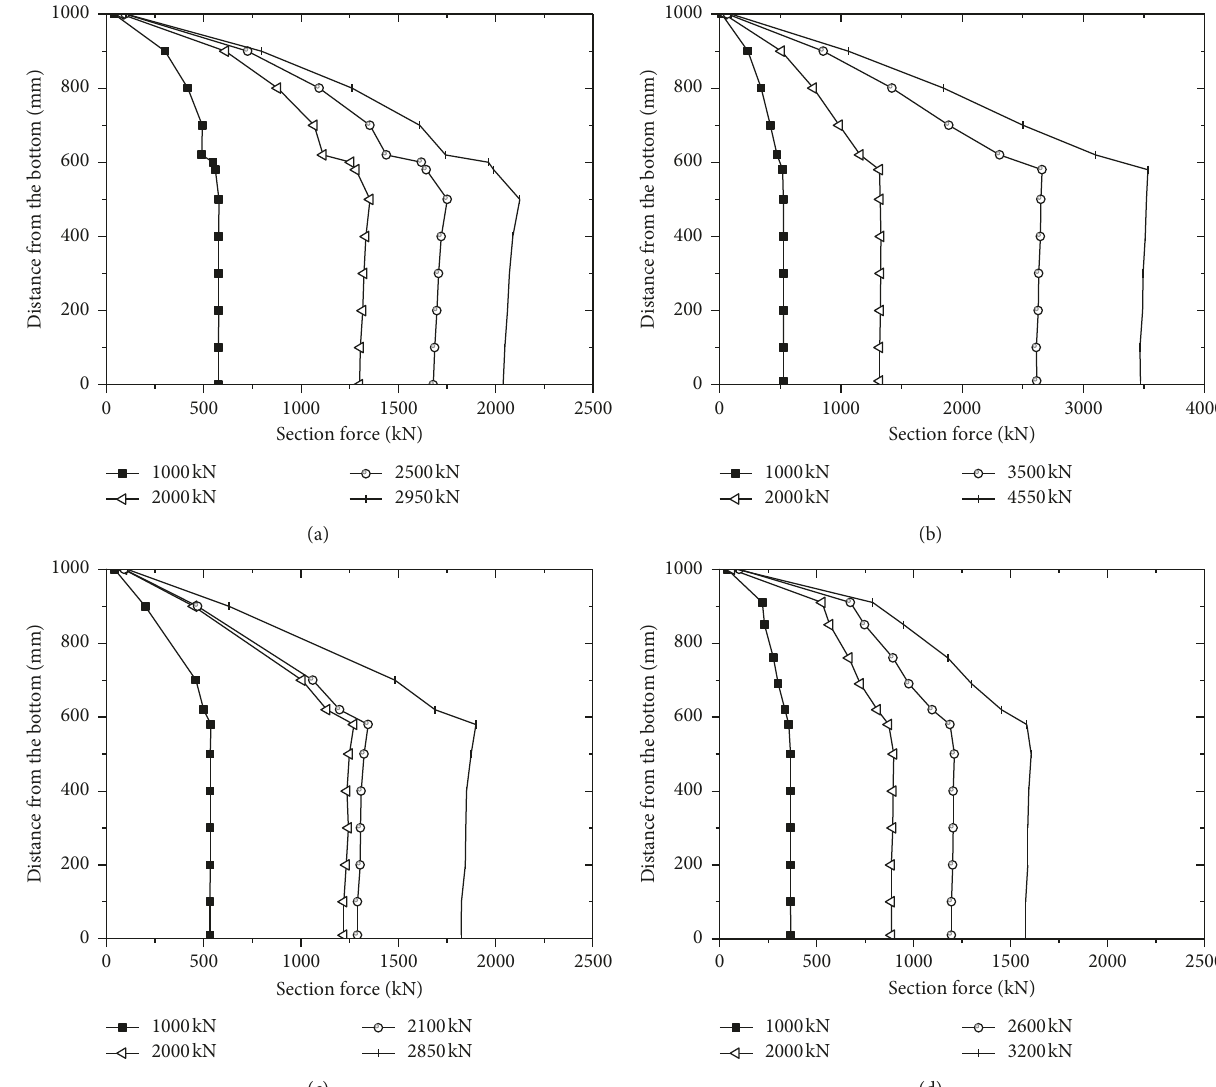
Figure 13: Height-axial force variation curves of steel tube section: (a) SJ-1; (b) SJ-2; (c) SJ-3; (d)